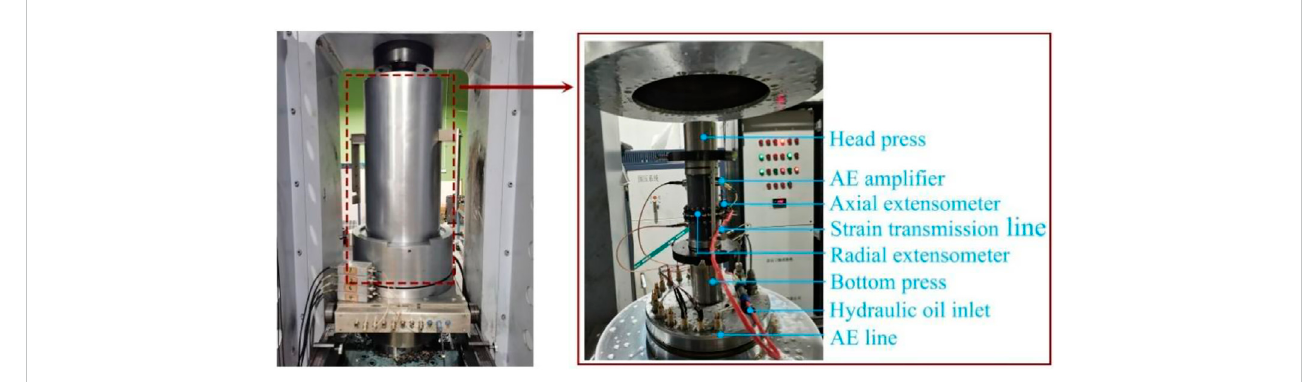
FIGURE 1 Rock mechanics test system and acoustic emission monitoring system.